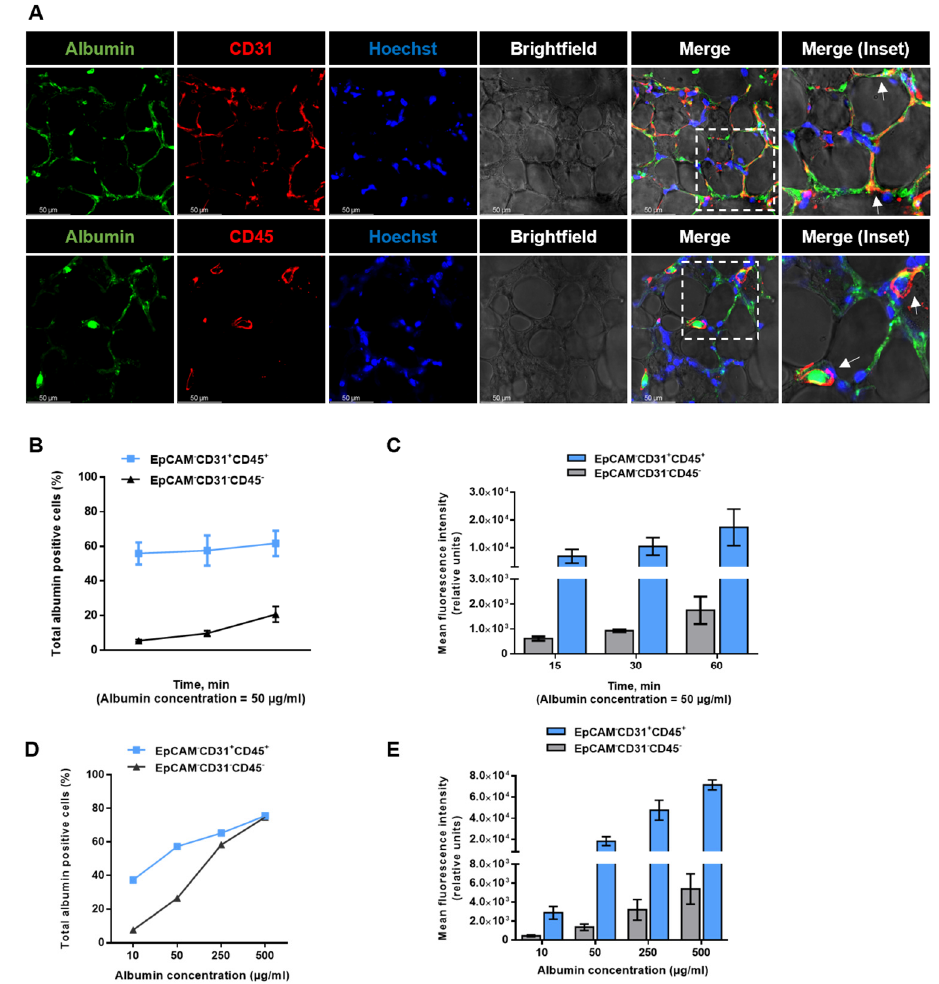
Figure 6. Albumin uptake in non-epithelial cell types in PCLS: ( A ) Murine PCLS were treated with AlexaFluor488-albumin for 60 min and then analyzed by confocal microscopy. Representative images of immunofluorescence staining of the endothelial cell marker, CD31, and the hematopoietic cell marker, CD45 (red), albumin (green), and nuclei (blue), in murine PCLS are depicted. The dashed line boxes mark the insets. The arrows show the co-localization of albumin and CD31 or CD45. Scale bar − 50 µ M. ( B , C ) Murine PCLS were treated with AlexaFluor488-albumin for up to 60 min, and percentage and mean fluorescent intensity of albumin-positive EpCAM − CD31 + CD45 + and EpCAM − CD31 − CD45 − cells were analyzed by FC. All bar graphs show mean ± SD ( n = 4). ( D , E ) Murine PCLS were treated with AlexaFluor488-albumin with different concentrations of labeled albumin, and percentage and mean fluorescent intensity of albumin-positive EpCAM − CD31 + CD45 + and EpCAM − CD31 − CD45 − cells were analyzed by FC. All bar graphs show mean ± SD ( n =